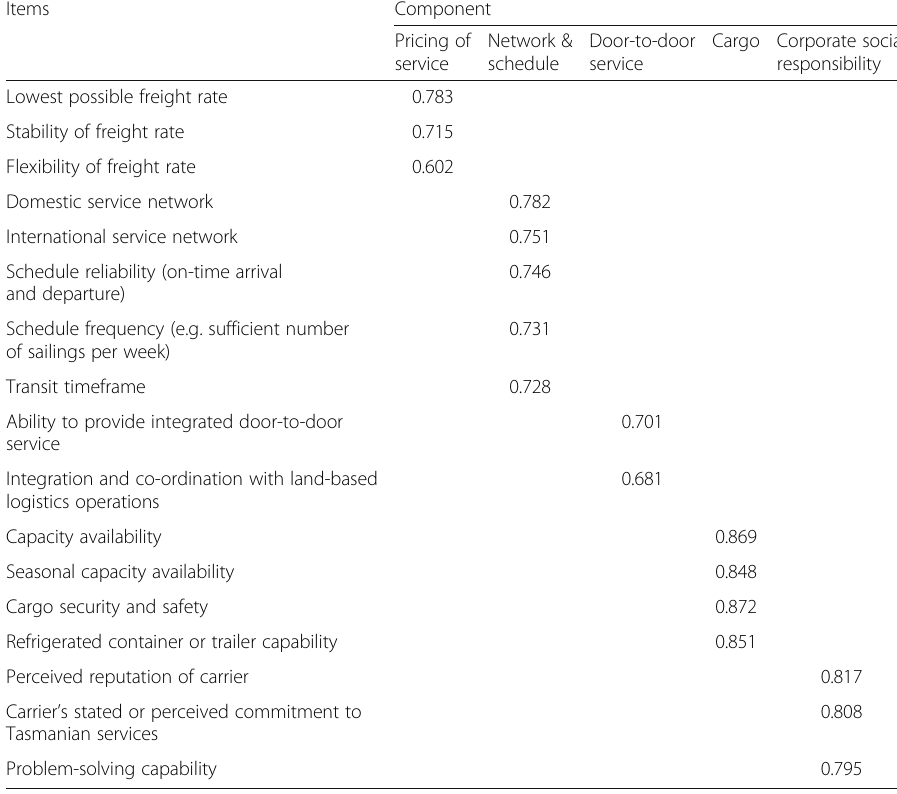
Table 2 Five Components Rotated - Pattern Matrixa